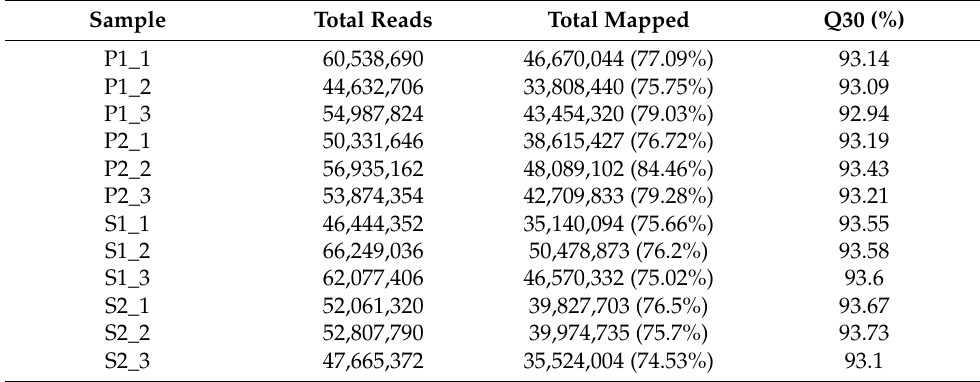
Table 1. The Sequence mapping after aligned to the genome of Camellia sinensis .